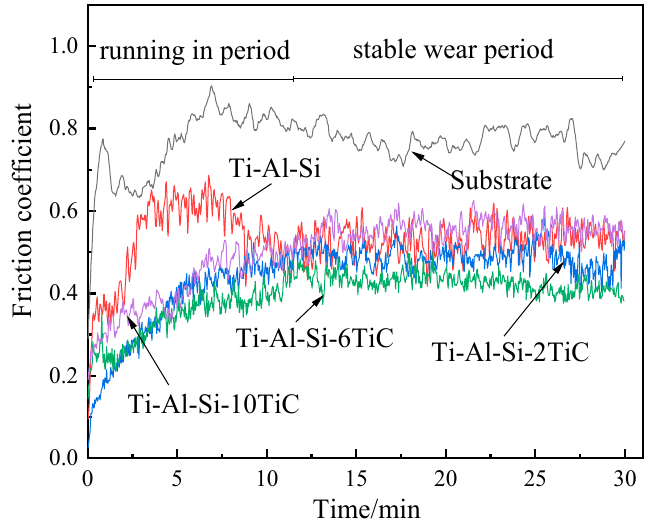
Figure 9. Typical evolution of friction coefficients of Ti-Al-Si- x TiC composites with sliding time.